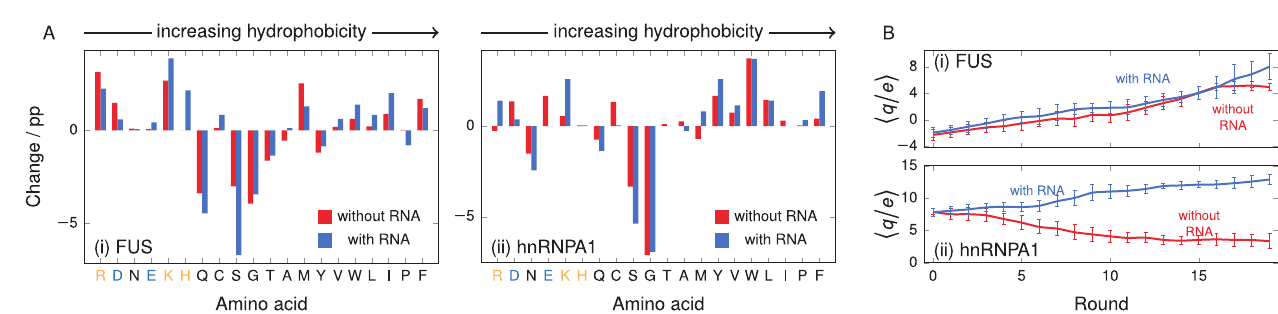
Fig 6. Changing the composition of the medium. (A) Percentage-point difference in amino-acid composition after increasing the phase diagram width for (i) FUS and (ii) hnRNPA1. Amino acids are plotted in order of increasing hydrophobicity [see Table A in S1 Text]. Positively charged amino acids are indicated in light orange and negatively charged ones in light blue. The ‘with RNA’ series corresponds to a system where 1/8 of the chains of the system are replaced with poly-U RNA of the same length as the IDR. (B) Charge content as a function of genetic-algorithm round for (i) FUS and (ii) hnRNPA1. Error bars give standard deviations for the population at each round. The addition of RNA changes the evolution behaviour significantly, particularly in the case of hnRNPA1, favouring higher charge content with the creation of new positive charges, illustrating that the evolutionary driving force depends not only on the initial sequence of the protein, but also on the medium around